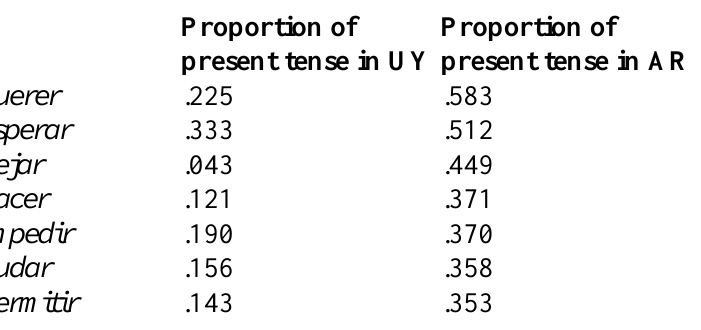
Table 10. Proportion of present subjunctive in embedded clauses following a past tense in the matrix